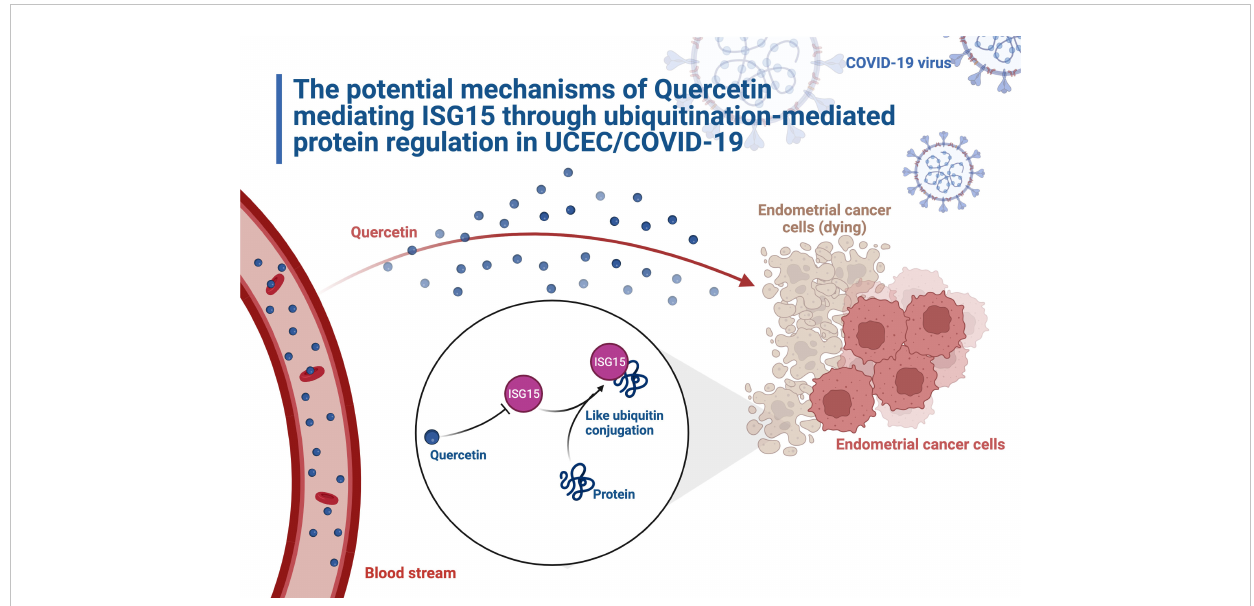
FIGURE 15 The schematic model illustrates how quercetin plays an anti-cancer role in